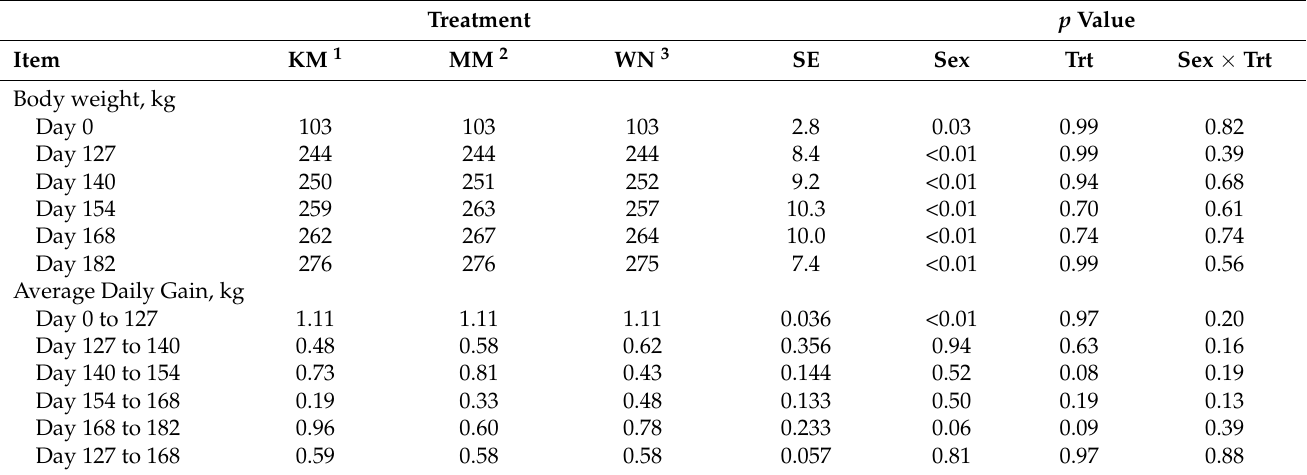
Table 1. Effect of vaccination type and timing of initial vaccination on growth performance of beef